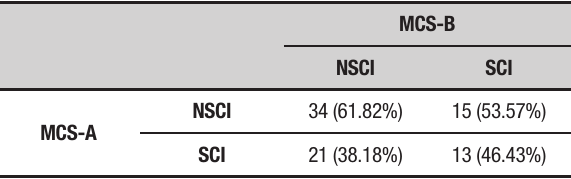
Table 4. Distinctions between MCS-A and MCS-B, according to column pro- file test.